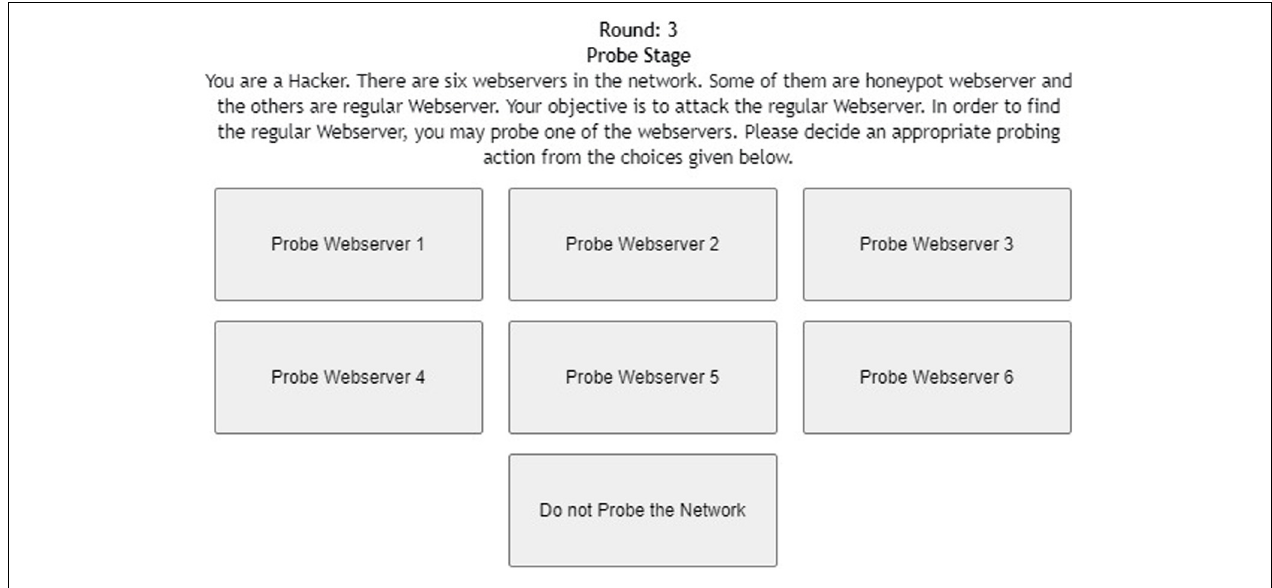
FIGURE 1 | Probe stage of the deception game with six web servers.